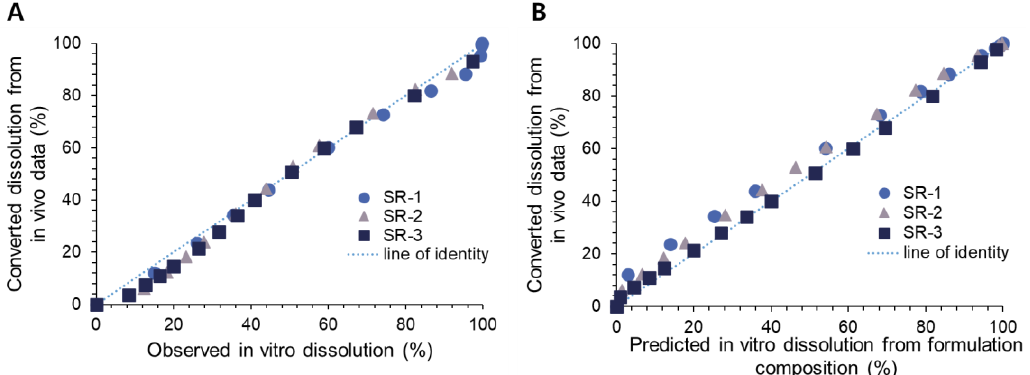
Figure 6. The correlation between the converted in vitro dissolution from in vivo data with the ob- served in vitro dissolution ( A ) and with the predicted in vitro dissolution from formulation compo- sitions ( B ).